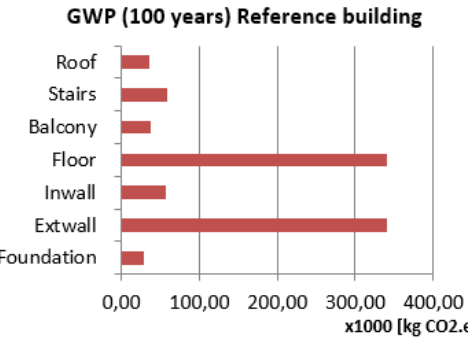
Figure 1. LCIA results of reference building (Source GaBi ts [37]).